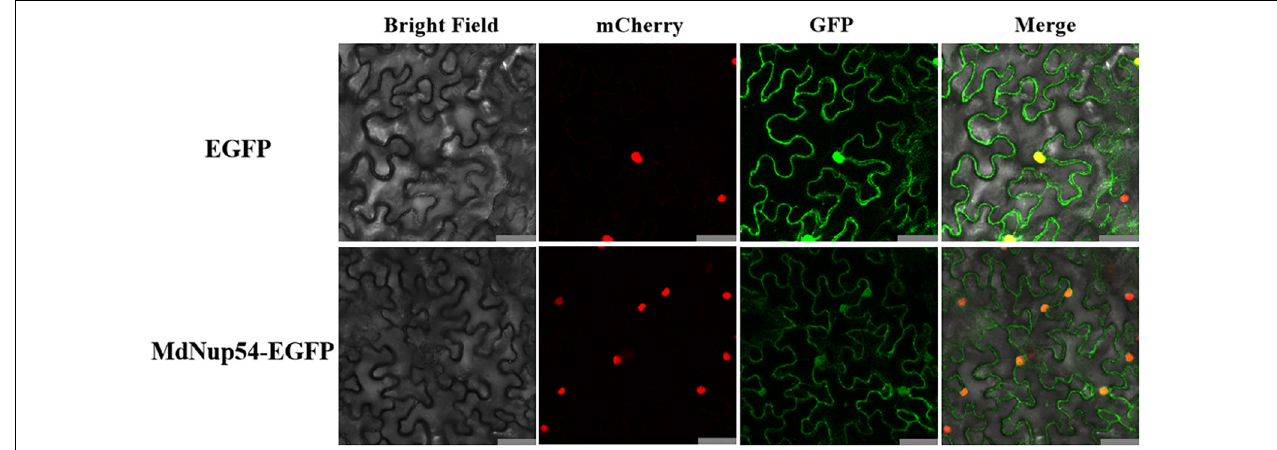
FIGURE 2 | Subcellular localisation of MdNup54. The upper panel shows 35S:EGFP, and the lower panel shows 35S:MdNup54-EGFP. Bar = 50 µ m.